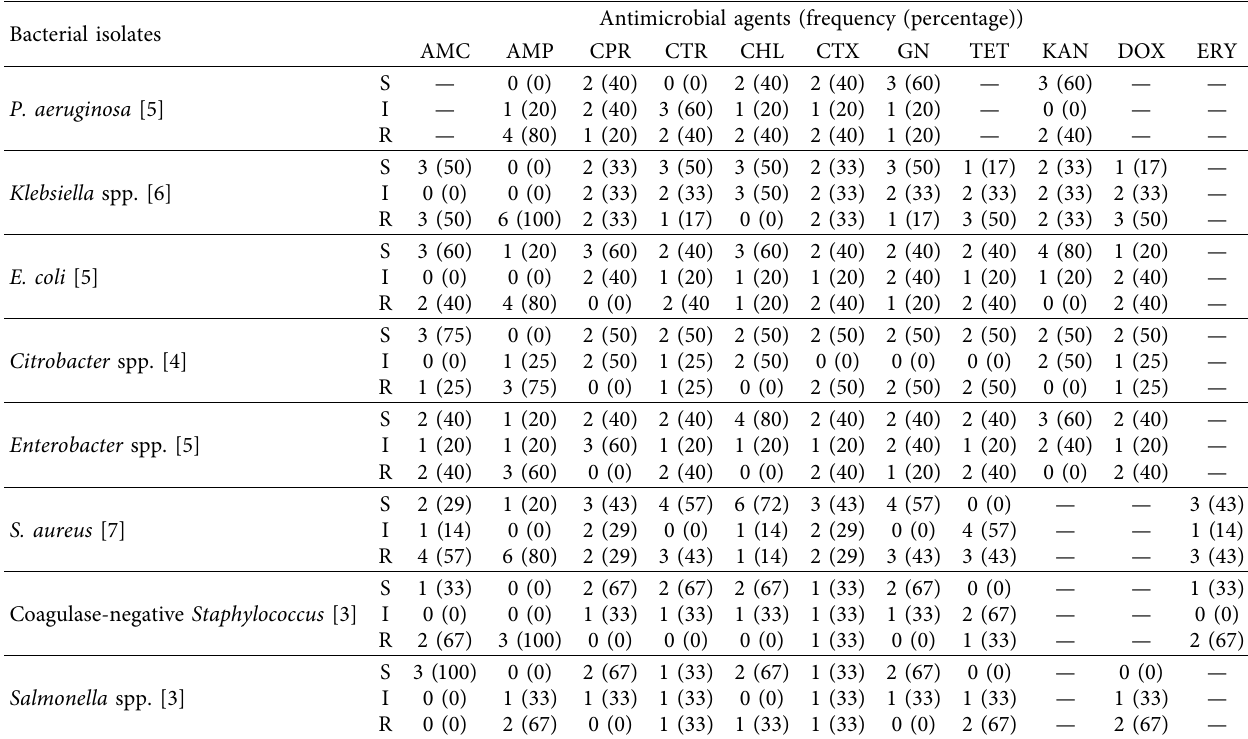
Table 2: Antibiotic susceptibility patterns of bacterial isolates from influent wastewater released from Arba Minch Hospital. Bacterial